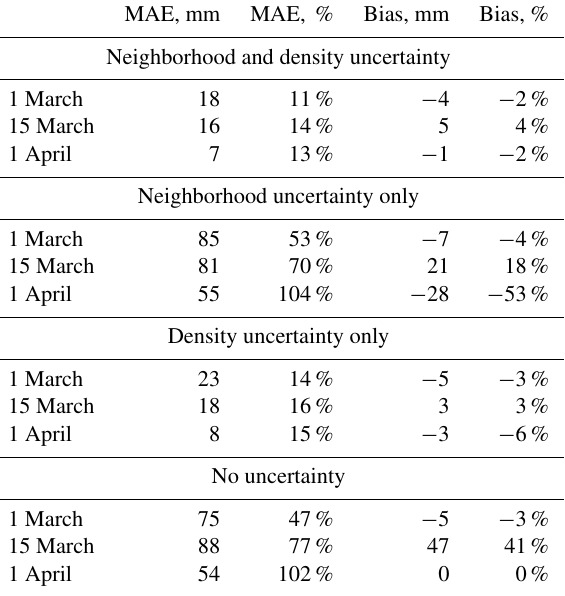
alpine and maritime areas is − 12 to + 26 % of SWE (Sturm et al., 2010).